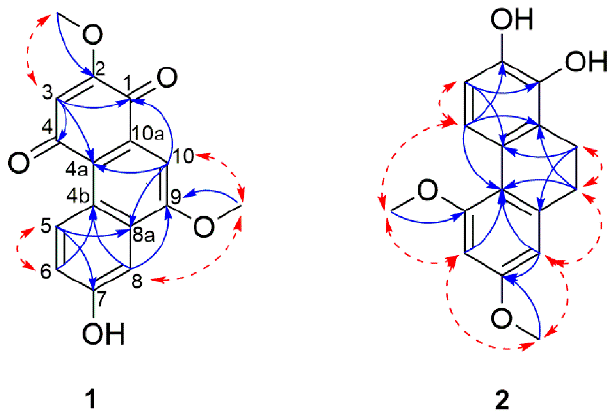
Figure 2. NOESY ( red dashed arrows) and HMBC ( blue arrows) correlations of compounds 1 – 2 .